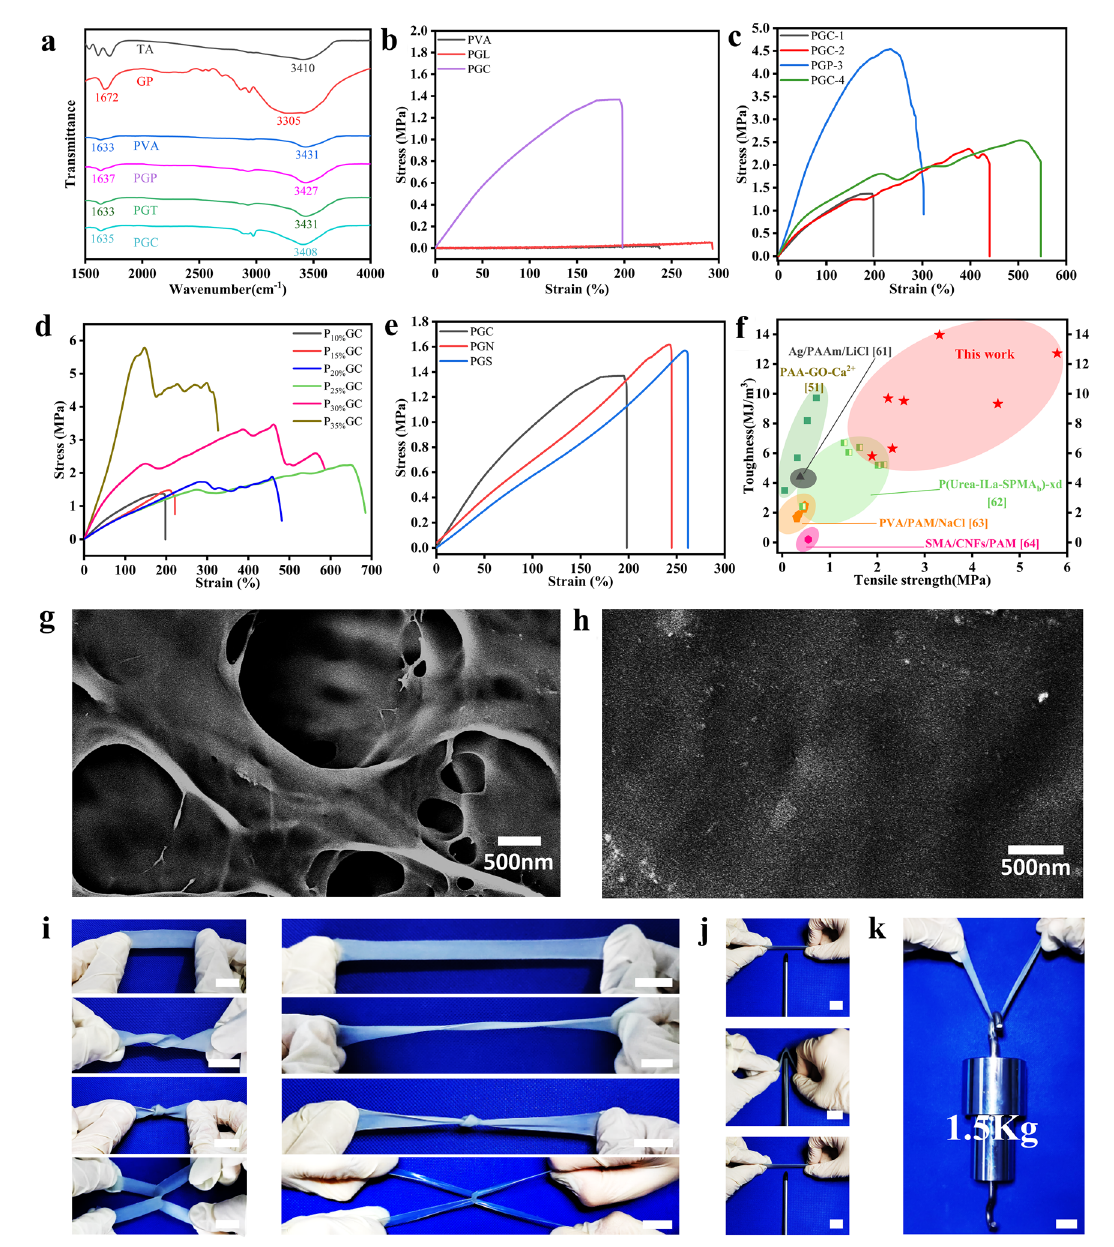
Fig. 2 Characterization of PGC hydrogel. Different hydrogels of a FTIR spectra and b tensile curves. c Strain–stress curves of PGC hydrogel with different Gp concentrations. d Strain–stress curves of PGC hydrogel with different PVA concentrations (10%, 15%, 20%, 25%, 30%, 35%). e Immersion in different ionic solutions for the same time (CaCl 2 , NaCl, sodium citrate). f Comparison plots of the hydrogel in this work with other tough/supramolecular hydrogels by toughness versus tensile strength. SEM images of g PVA and h PGC hydrogels at same magnifications. Tensile deformation including: i stretching, twisting stretching, knotting stretching, crossing stretching and j puncture resistance. k Lifting an object 1500 times heavier than itself without damage. Scale bars: 2 cm in ( i–k